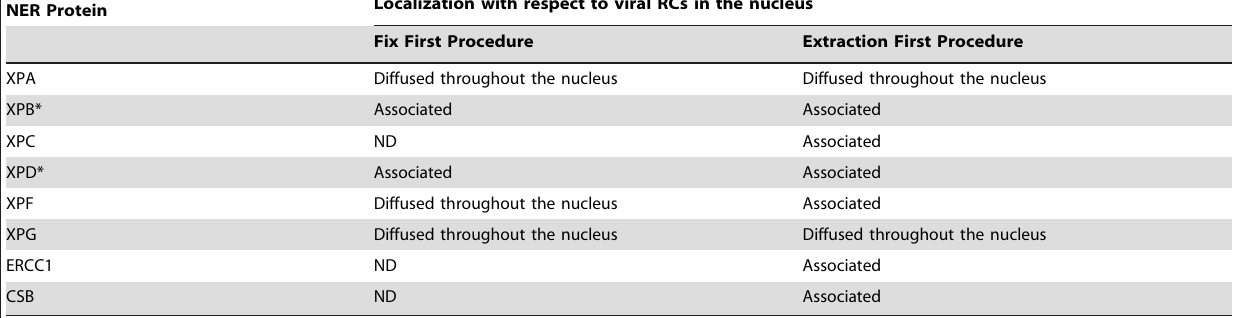
Table 1. Localization of NER proteins within the